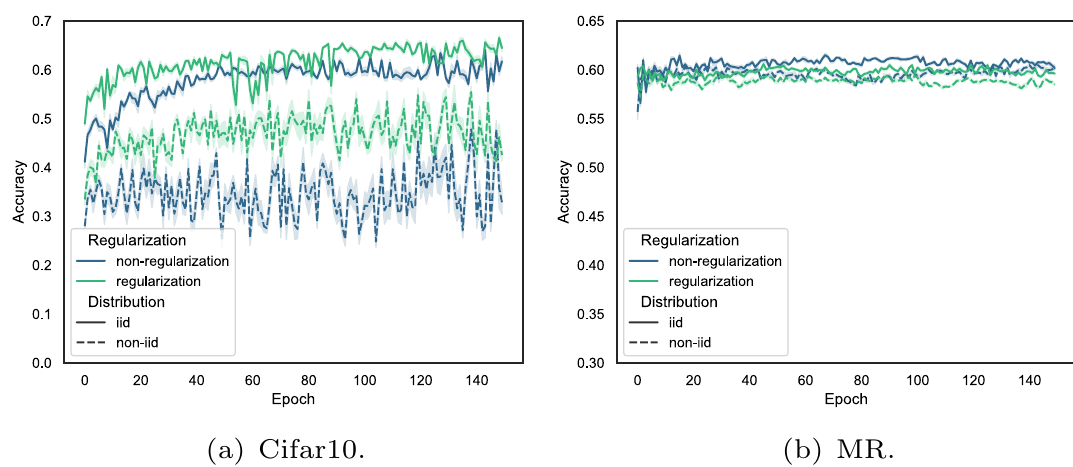
Fig. 10 Model performance comparisons on whether to add a regularization term under different distributions